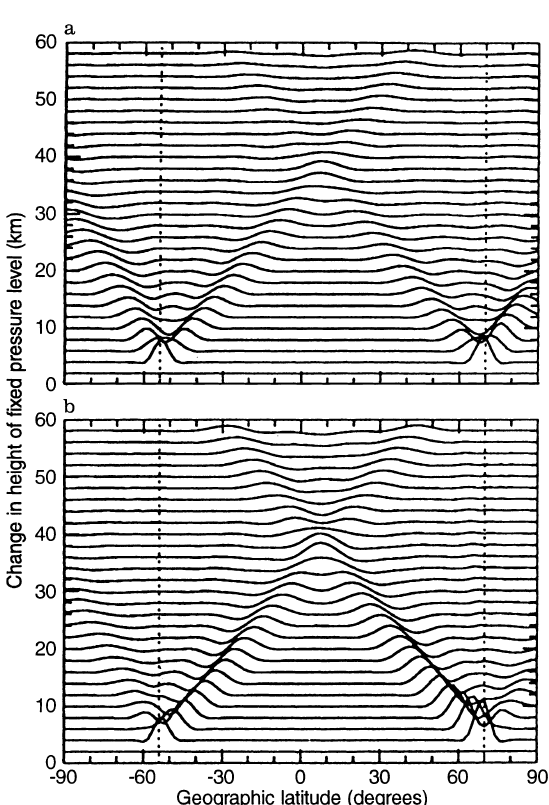
Fig. 2a,b. The change in the height of the fixed pressure level H12 plotted against latitude on the line of longitude 162 (cid:14) E, due to a short duration localised enhanced electric field a meridionally, and b zonally. The change in the height of the fixed pressure level has been shown at 30 consecutive intervals, each 10 min apart from t (cid:136) 0 to t (cid:136) 290min, each successive plot beyond the first displaced 2 km on the vertical axis for clarity. The enhanced electric field disturbance lasted from t (cid:136) 15 to t (cid:136) 25min, and the locations of the centres of enhancement of the electric field are shown by vertical broken lines